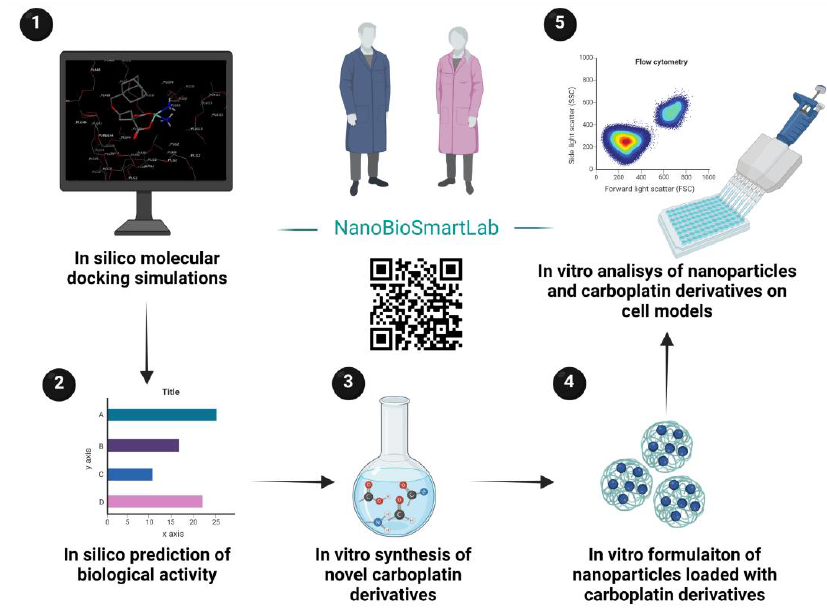
Figure 3. Research graphical workflow.